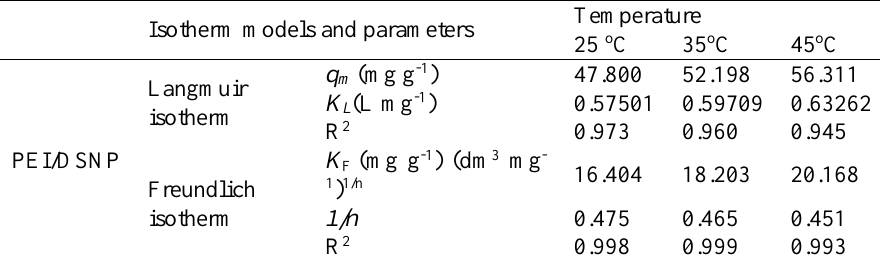
Table 4. Parameters of adsorption isotherms of Pb 2+ ions adsorption on